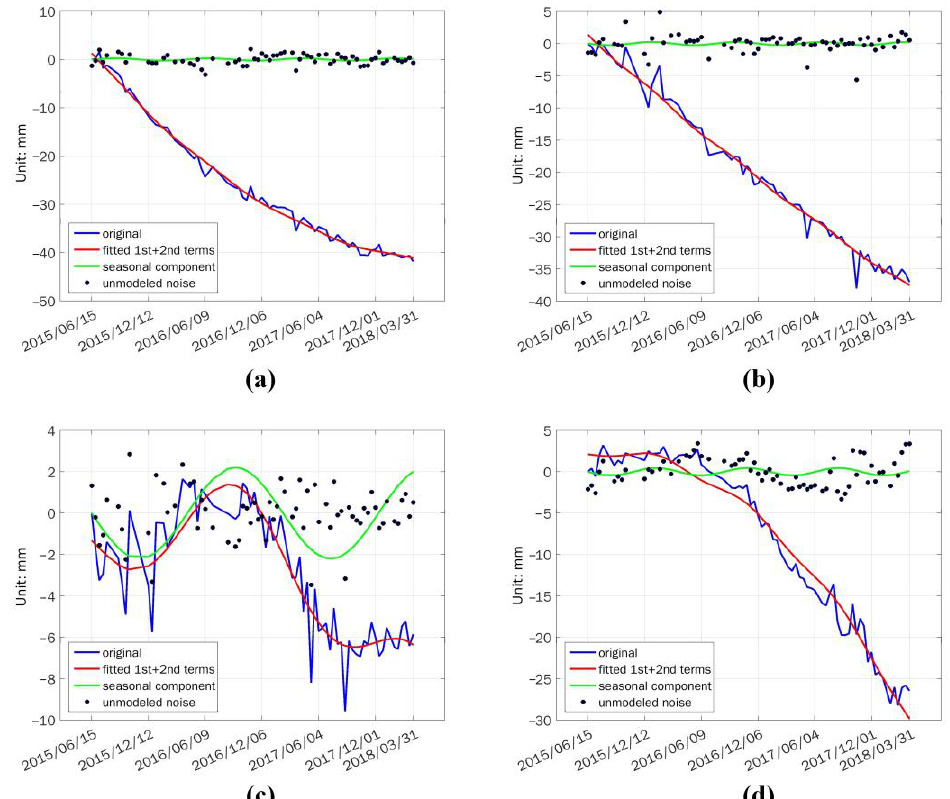
Figure 5. PS time series decomposition results of representative PS points after tropospheric correction using ERA5 and spatiotemporal filtering. ( a ) “P1” in the Qianhai sub-area; ( b ) “P2” in the HKIA sub-area; ( c ) “P3” in the Wutong Mountain sub-area; ( d ) “P4” in the Liantang sub-area. The blue line shows the original PS time series measurements. The red line plots the sum of the fitted first term and second term in Equation (1) by time series decomposition. The green line displays only the periodic component. The black dots represent the unmodeled noise as defined in Equation (1).